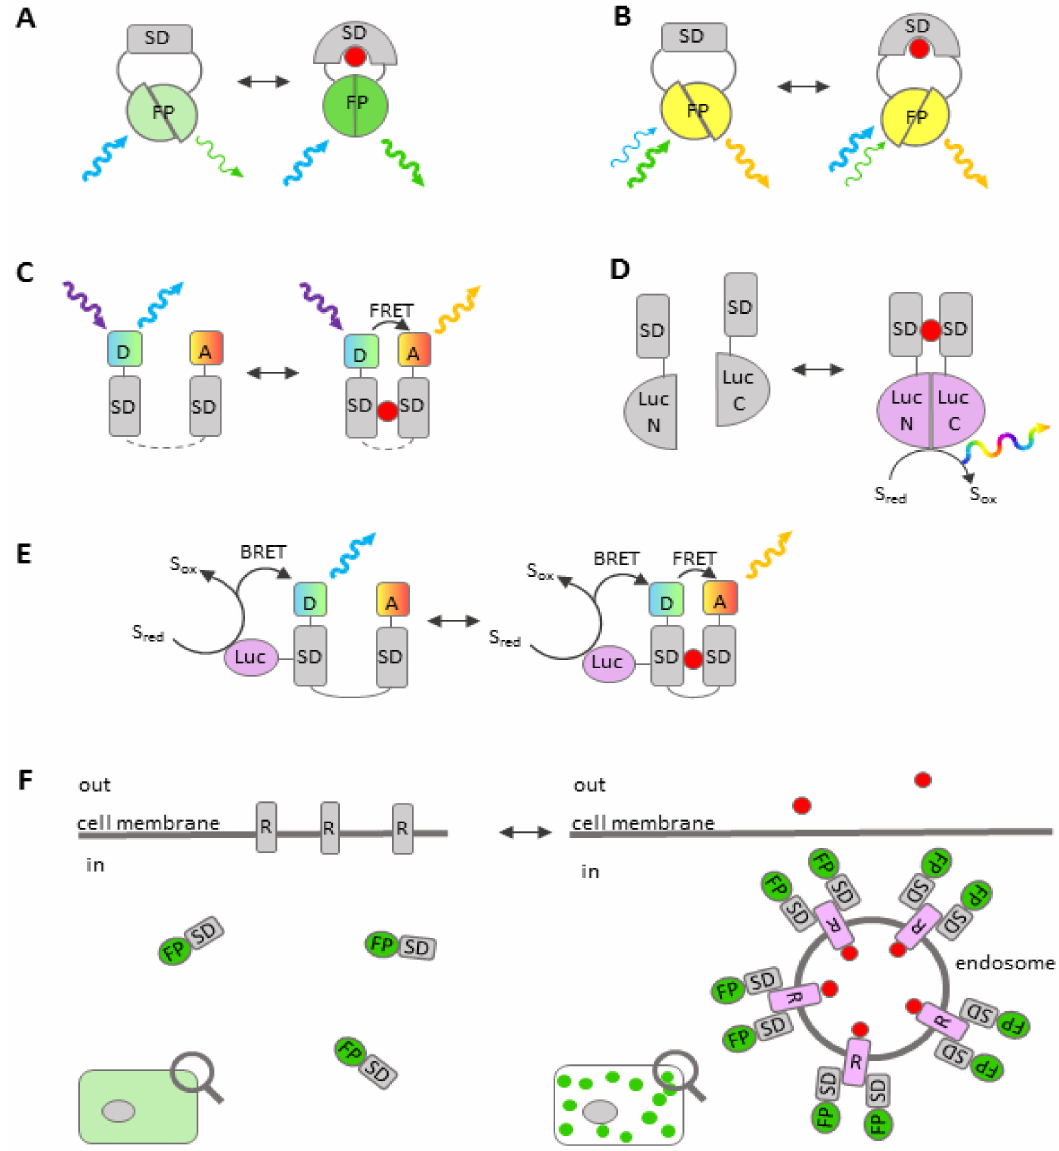
Figure 2. Schematic diagram of fluorescent sensors readouts. ( A ) Single-wavelength ratiometric sensor. After the sensory domain (SD) binds the ligand (red circle), which may be a metabolite, a posttranslational modification, or a protein motif, the conformational change occurs, and the emission of the fluorescent protein (FP) increases. ( B ) Ratiometric sensor based on a single FP. After ligand binding, the conformational change leads to alterations in the absorbance spectrum of the reporter FP. ( C ) FRET-based sensor. In the “open” conformation (or if the subunits of the sensor are separated from each other) resonance energy transfer is ineffective, and only the donor FP (D) fluoresces when excited. In the “closed” conformation, FRET occurs, and the acceptor FP (A) fluoresces when the donor FP is excited. ( D ) Bioluminescent intensiometric sensor. After the ligand binding, the separated N-terminal and C-terminal fragments of luciferase (N-Luc and C-Luc, respectively) arrange an active enzyme capable of converting the reduced substrate (Sred) into the oxidized form (Sox). The wavelength of bioluminescence emitted depends on the substrate. ( E ) HyBRET sensor. (A) luciferase molecule (Luc) is fused to the donor FP and excites it by bioluminescence resonance energy transfer (BRET). Depending on the sensor conformation, the donor FP emits fluorescence or transfers the energy to the acceptor FP. ( F ) Reporter system based on target translocation. When the target molecule is activated (by posttranslational modification, conformational change, etc.), it binds the fluorescent reporter and changes its distribution in the cell. For example, a membrane receptor (R) can recruit the reporter after ligand binding, and, due to the receptor internalization, reporter granules can be